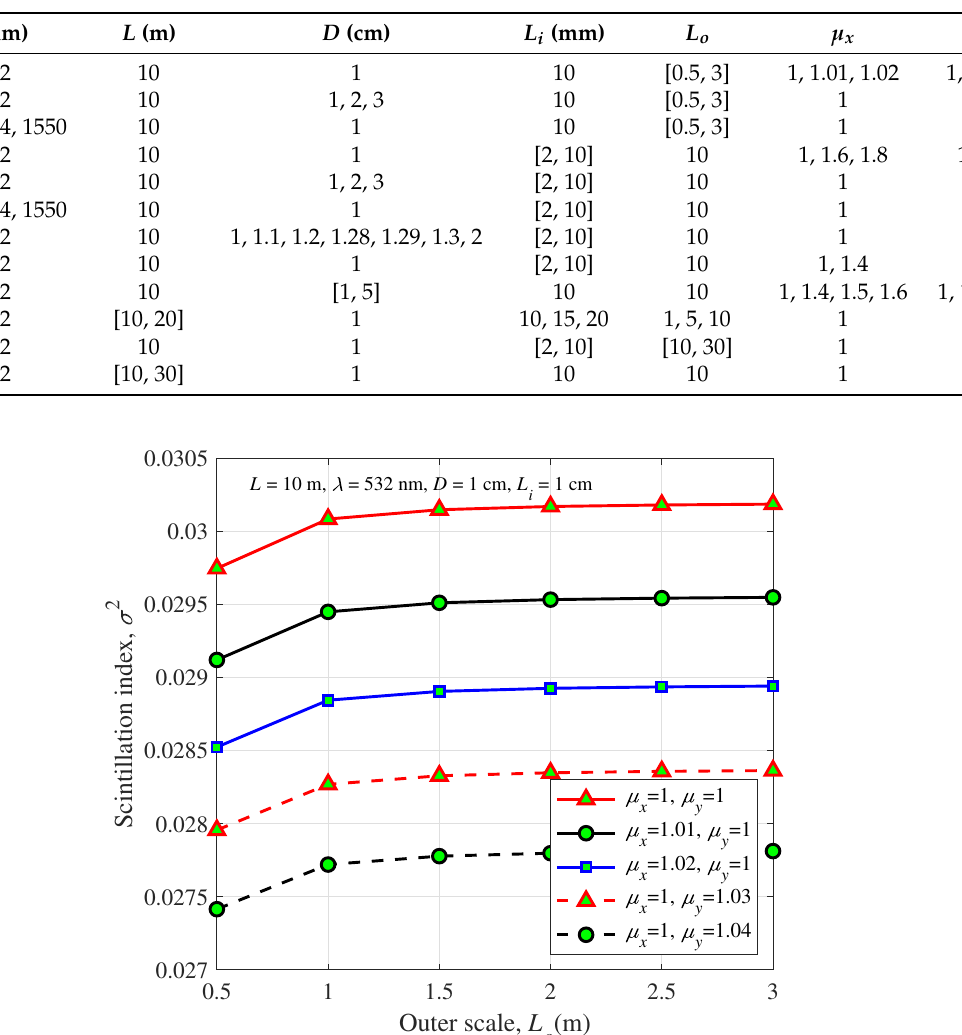
Table 1. Key parameters used in calculations..